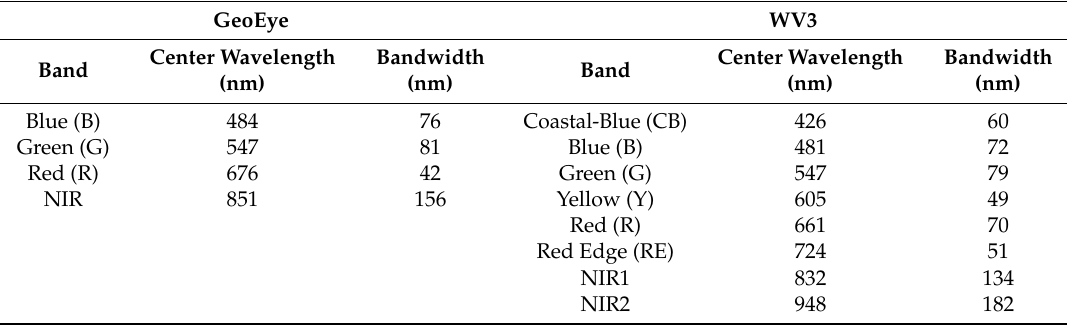
Table 1. Multispectral band designations for GeoEye and WV3 sensors